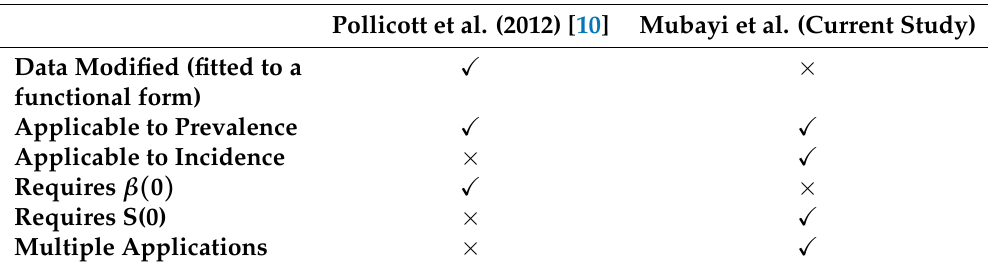
Table 1. Some common differences and similarity in estimation methodology between the current study and that in Pollicott et al.